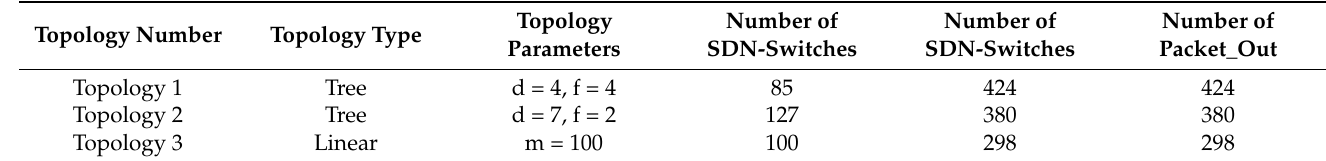
Table 2. Number of Packet_Out messages in different topologies